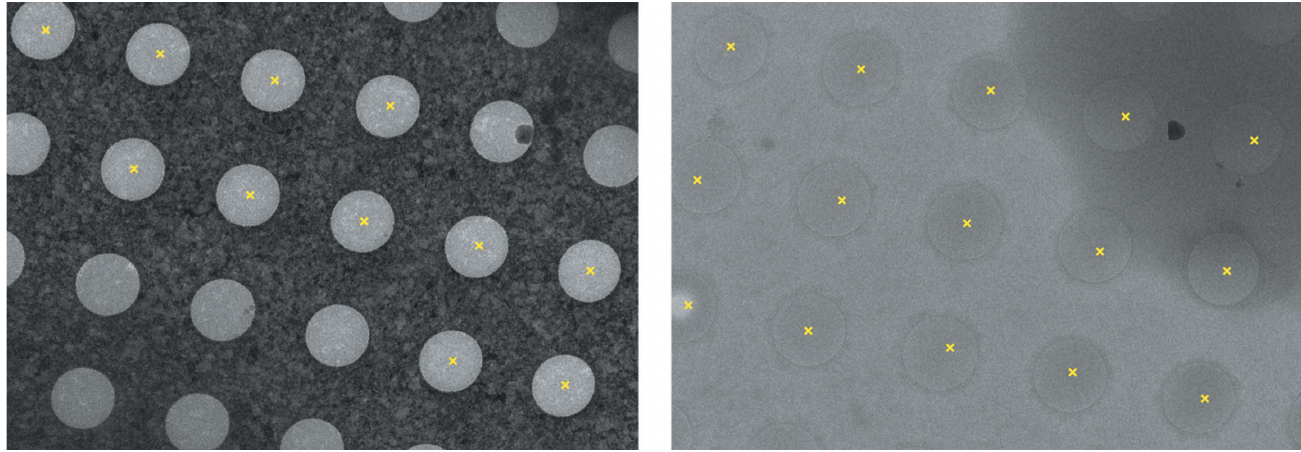
Figure 5 Example medium-magnification images. Human operator-selected locations are marked in yellow. The input to the U-Net is the image without any marking for the selection locations, and the output is a map with a 1 at each pixel where a selection was made and 0 elsewhere. In rare cases (right), holes can be darker than the surrounding region.